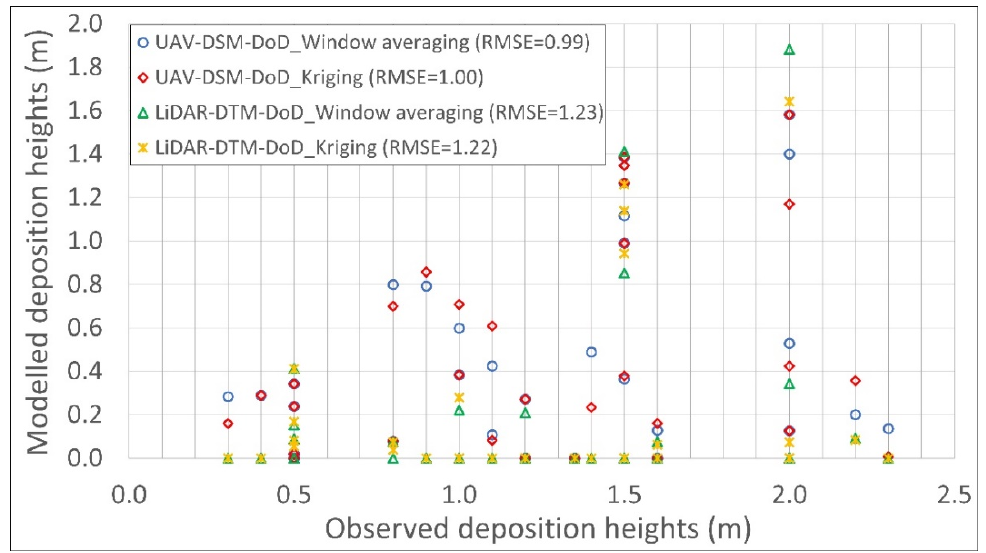
Figure 8. Observed deposition heights versus modelled deposition heights for 30 locations of data collection in Coulibistrie. RMSE between observed and modelled values per method is given in the legend.